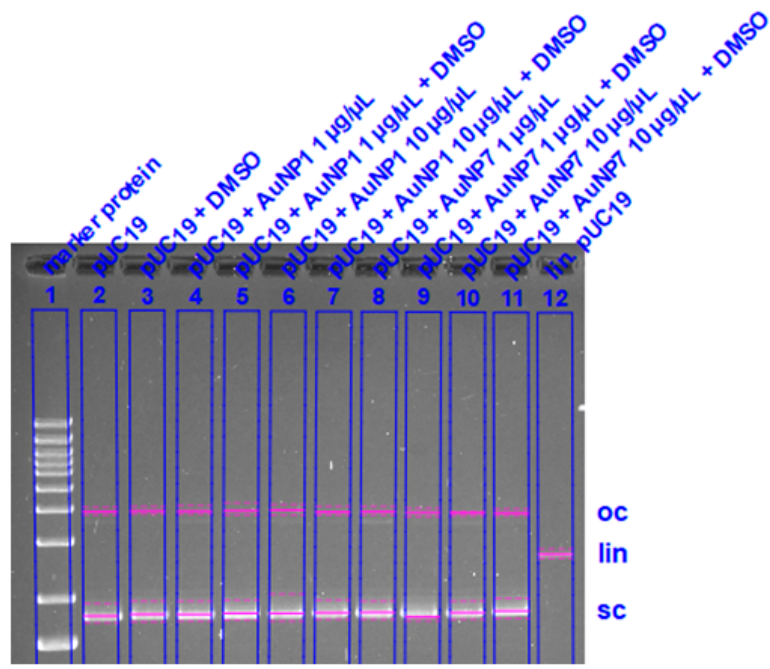
Figure A19. Evaluation of influence to DNA degradation of AuNP 1 and 7 at a concentration of 1 and 10 µ g/mL with and without 2 M DMSO via gel electrophoresis. Left line is the marker protein. The lowest bands show intact sc-DNA, middle bands show lin-DNA with DSBs, and the highest band show oc-DNA with SSBs. The direction of elution is from top to bottom.